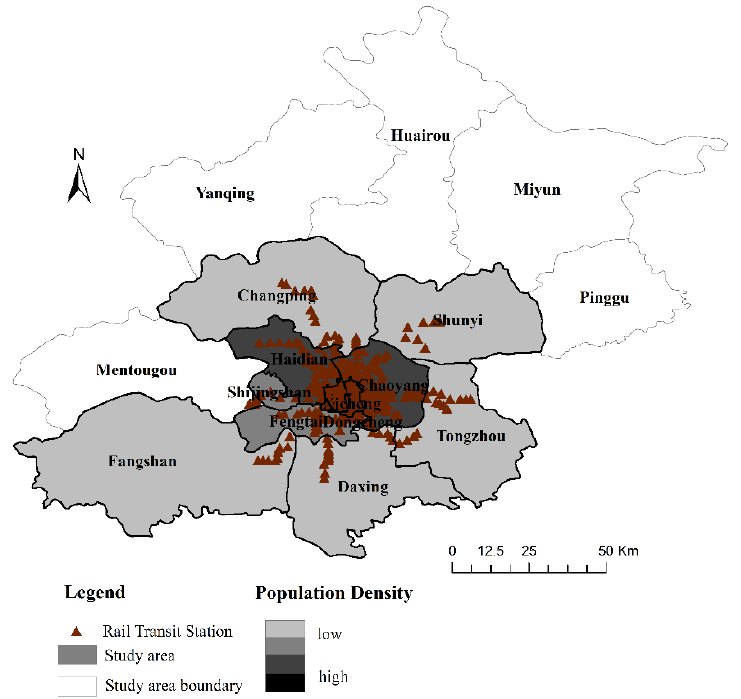
Figure 1. Distribution of Beijing Rail Transit Lines.